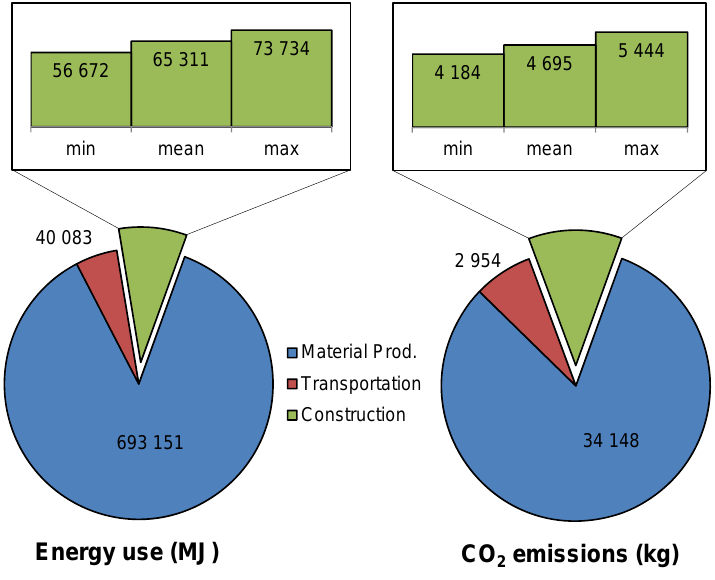
Figure 4. The energy use and CO 2 equivalent emissions of each